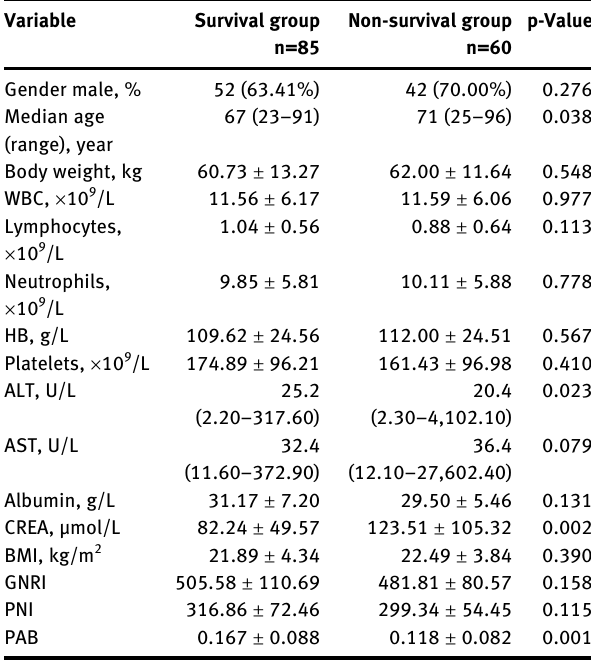
Table  : Baseline patients ’ characteristics.